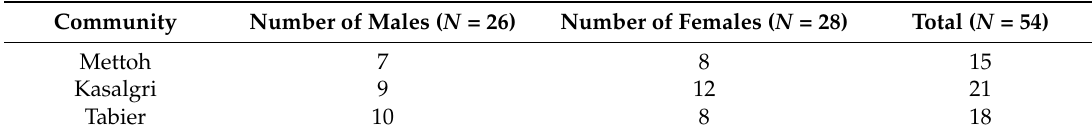
Table 1. Communities and focus group sample